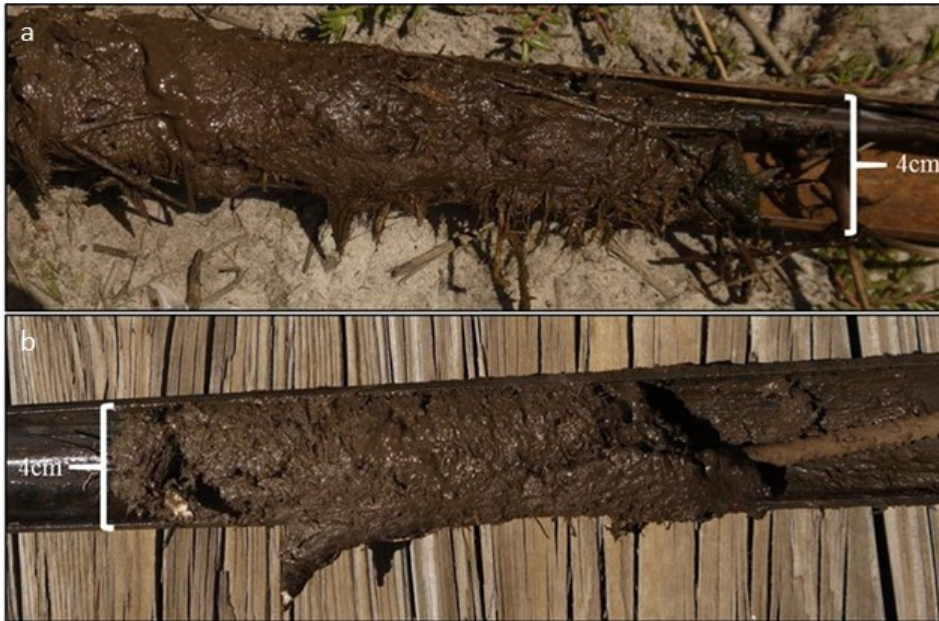
Figure 2. The top photograph ( a ) shows a soil core from a salt marsh site with abundant grass fragments. The bottom photograph ( b ) shows a soil core from a mangrove site with fibrous roots, sticks, and woody fragments. Both of these images include the sediment surface (right side of each).